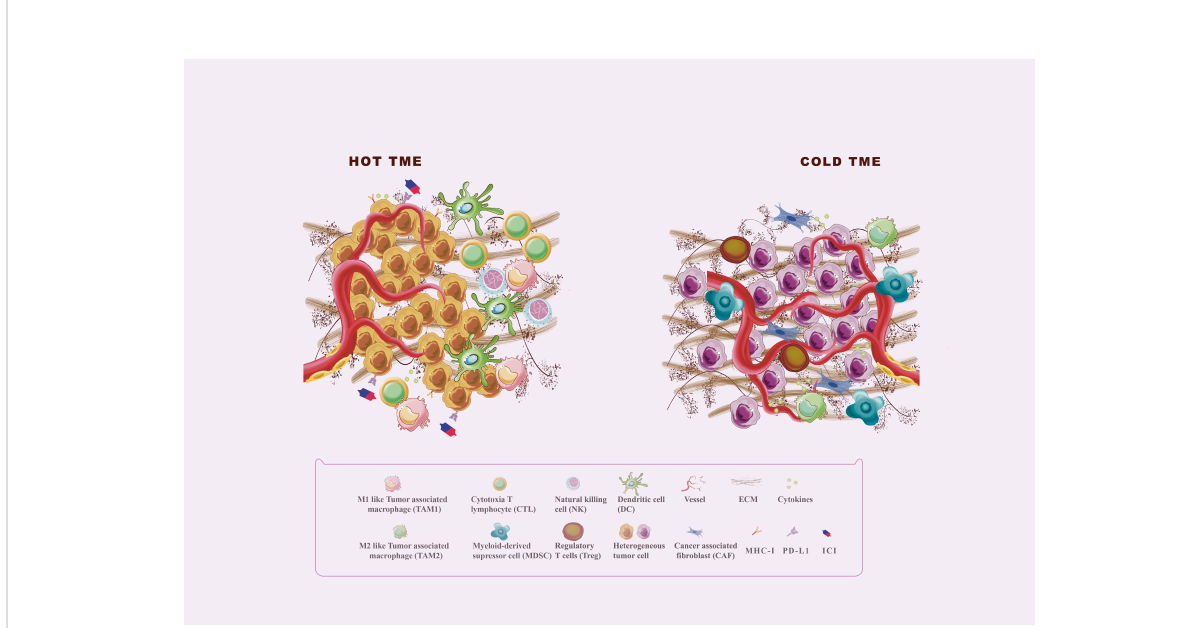
FIGURE 1 Hot and cold TME. The tumor microenvironment (TME) is divided into the immune desert (cold) and immunoin fl ammatory (hot) phenotypes. In the immune desert phenotype, the absence of T cells in the tumor may be due to the lack of tumor antigens and antigen-presenting cells (APC), the secretion of immunosuppressive molecules such as TGF- b and IL-10, and the in fi ltration of immunosuppressive cells including MDSC, M2 macrophages, and Treg. In addition, abnormal angiogenesis and excessive ECM also play an important role in the formation of cold TME. The immunoin fl ammatory phenotype is thought to be a prominent in fi ltration of cytotoxic T lymphocytes (CTLs) in the core of the TME, with activated antigen-presenting cell (APC) markers and type 1 interferon (IFN)